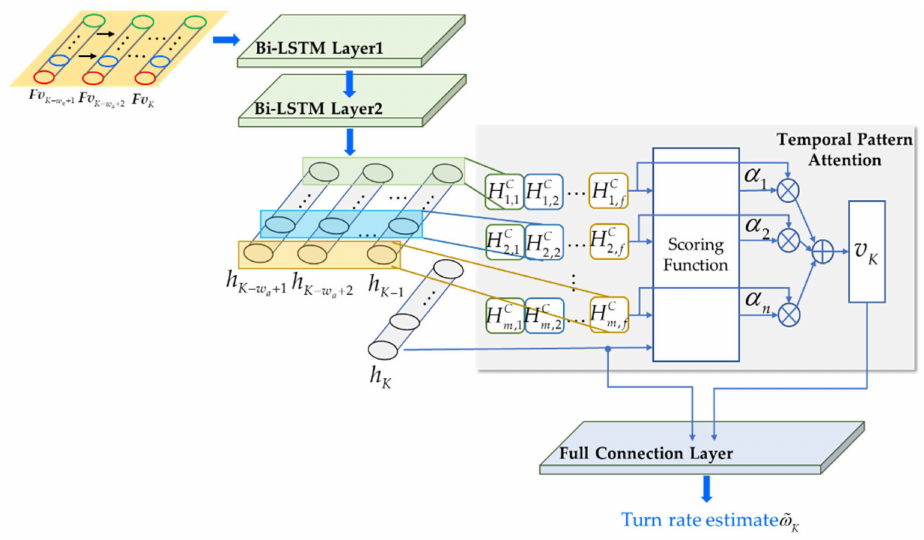
Figure 2. Structure of the adaptive turn rate estimation